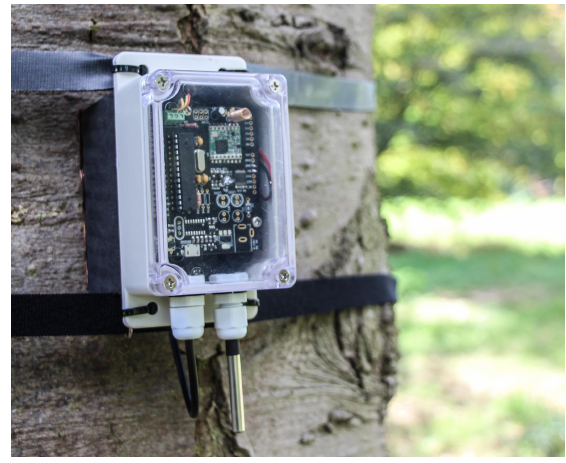
Figure 6. Application: the proposed platform is employed as a sensor for monitoring the health of